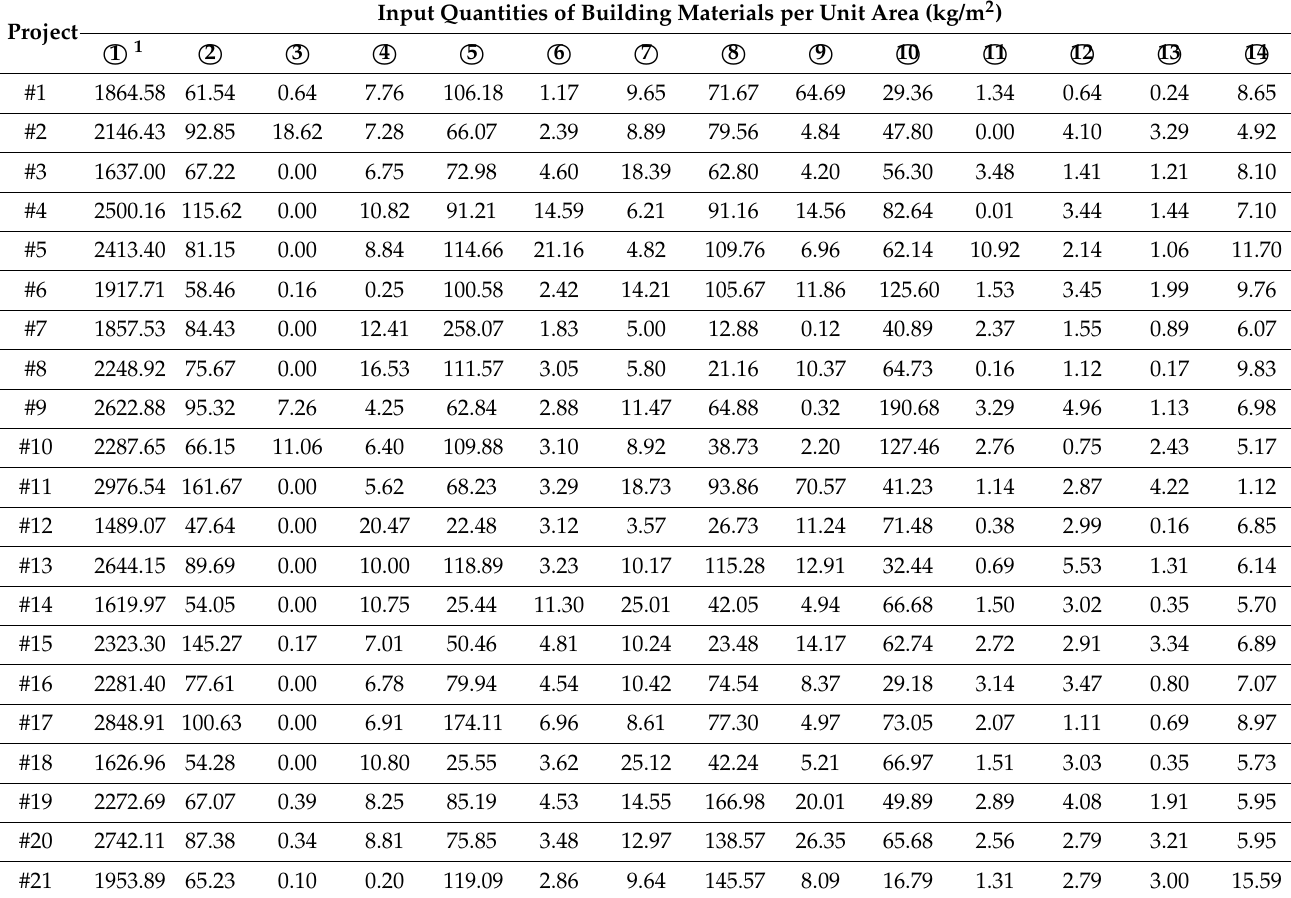
Table 2. Input quantity samples of building materials per unit